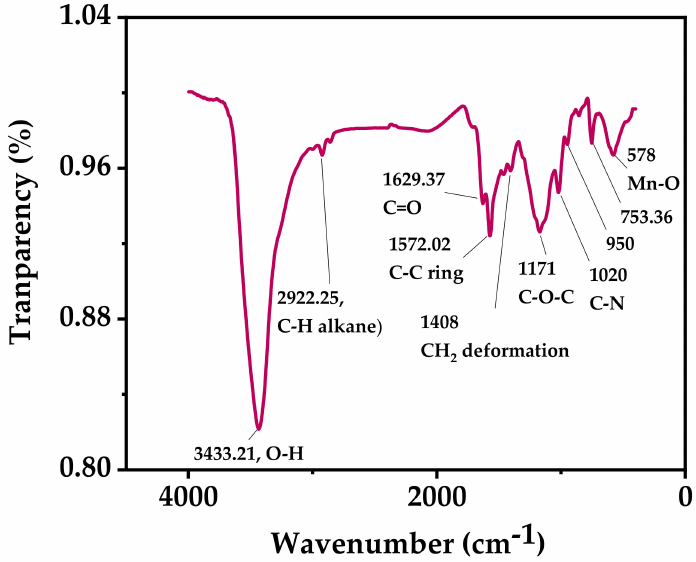
Figure 7. FT-IR spectrum of